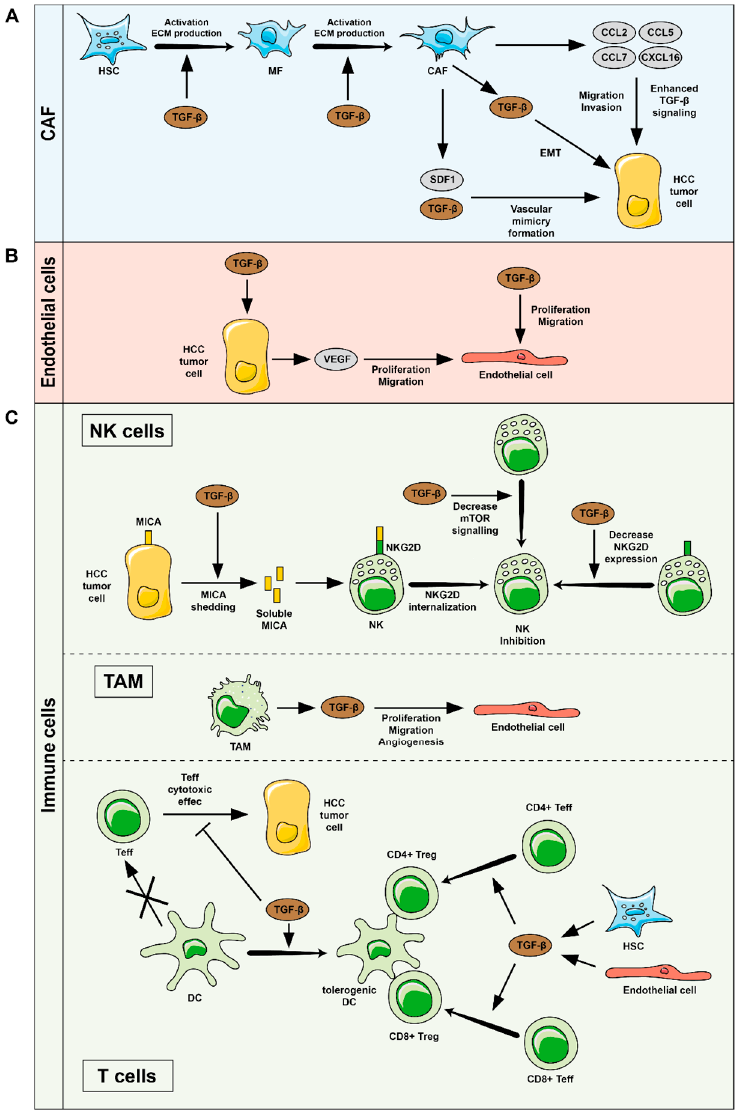
Figure 2. Schematic representation of the effects of TGF- β on the stromal cell types of hepatocellular carcinoma. ( A ) Effects on CAF: TGF- β stimulates the activation of HSC and the maintenance of the myofibroblastic phenotype, which, upon malignant transformation of hepatocytes into HCC cells, become CAF. CAF produce (i) TGF- β , that acts on HCC cells inducing EMT, and enhance vascular mimicry formation in HCC cells together with SDF1, (ii) other chemokines (CCL2, CCL5, CCL7 and CXCL16) that enhance TGF- β activity on HCC cells leading to metastasis. ( B ) Effects on endothelial cells: TGF- β may promote migration and proliferation of endothelial cells by (i) directly acting on endothelial cells or (ii) inducing VEGF secretion by HCC cells. ( C ) Effects on the immune system: TGF- β may increase the levels of soluble MICA and weaken the action of natural killer (NK) cells through its binding to NKG2D. TGF- β can also downregulate NKG2D expression or repress the mTOR pathway impairing tumor recognition. TGF- β can also act on tumor associated macrophages (TAM) that secrete growth factors and promote migration of endothelial cells and angiogenesis. TGF- β can favor the generation of tolerogenic dendritic cells (DC) and impair the activation of effector T lymphocytes and their cytotoxic activity. TGF- β promotes the conversion of conventional CD4 or CD8 T cells into immunosuppressive Treg cells that can hinder the antitumor activity of the adaptive immune response. CAF: cancer associated fibroblasts, ECM: extracellular matrix, EMT Epithelial-Mesenchymal Transition, HSC: hepatic stellate cells, MF: myofibroblasts, Teff: effector T cells, Treg: T regulatory cells.